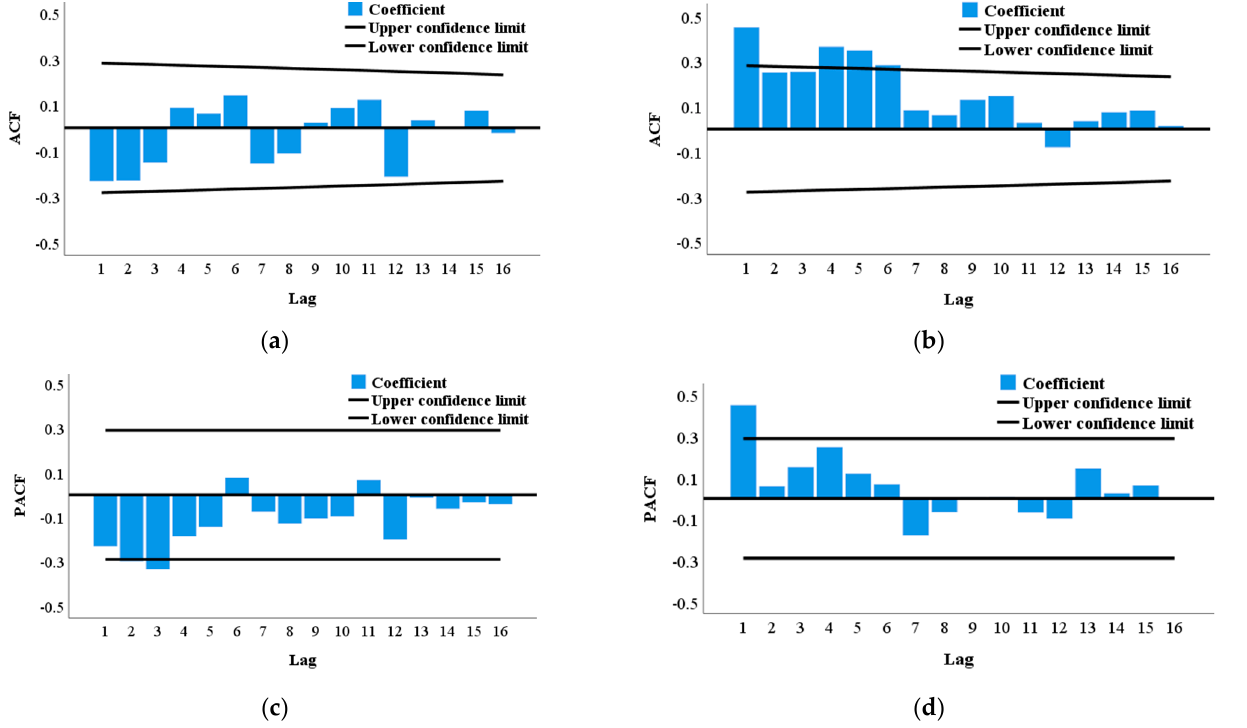
Figure 4. Autocorrelation function and partial autocorrelation function. ( a ) ACF ( d = 1, D = 1), ( b ) ACF ( d = 0, D = 1), ( c ) PACF ( d = 1, D = 1), ( d ) PACF ( d = 0, D = 1). Table 3. Statistics of BIC values.